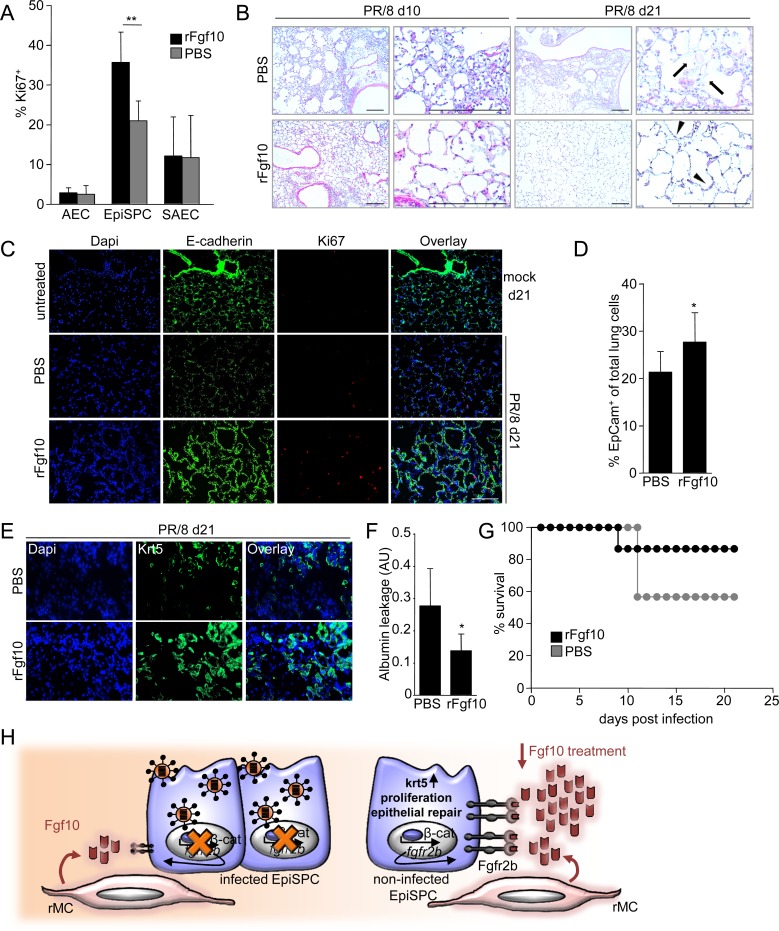
Therapeutic treatment with recombinant Fgf10 improves influenza virus-induced lung injury and improves re-epithelialization and barrier repair.Wt mice were infected with PR/8 and treated with a single dose of either 5μg recombinant Fgf10 (rFgf10) or diluent (PBS-/-) at d6 pi. (A) The proliferative response of EpCam+ epithelial cell subsets was determined by flow cytometry at d7 pi. (B) Lung sections were stained with hematoxylin-eosin at d10 and d21 pi. Arrows depict non-epithelialized alveolar tissue; arrowheads depict areas of ongoing re-epithelialization. (C) Immunofluorescence staining of lung sections for E-cadherin (green), Ki67 (red), and Dapi (blue) at d21 pi. The top row shows lung tissue from mock-infected, untreated mice at d21. (D) Quantification of total lung epithelial cells (EpCam+) in lung homogenates at d14 pi. (E) Lung sections were stained for krt5 (green) and Dapi (blue) at d21 pi. (F) Lung barrier function was analysed by quantification of alveolar leakage of FITC-labeled albumin at d14 pi. Values are given in arbitrary units (AU) and represent ratios of FITC fluorescence in BALF and serum. (G) Survival of n = 8 mice per treatment group was analysed until d21 pi. Bar graphs represent means ± SD of n = 5–6 independent experiments; * p<0.05; **p<0.01. Photomicrographs are representative for n = 3–4 independent experiments; bars = 200 μm. (H) Summary: IV with high pathogenicity infect a substantial fraction of EpiSPC, resulting in inhibition of β-catenin-dependent Fgfr2b upregulation and impaired epithelial repair mediated by rMC-expressed Fgf10. Therapeutic application of excess Fgf10 antagonizes IV-induced regeneration failure by engagement of non-infected, Fgfr2bhigh EpiSPC.